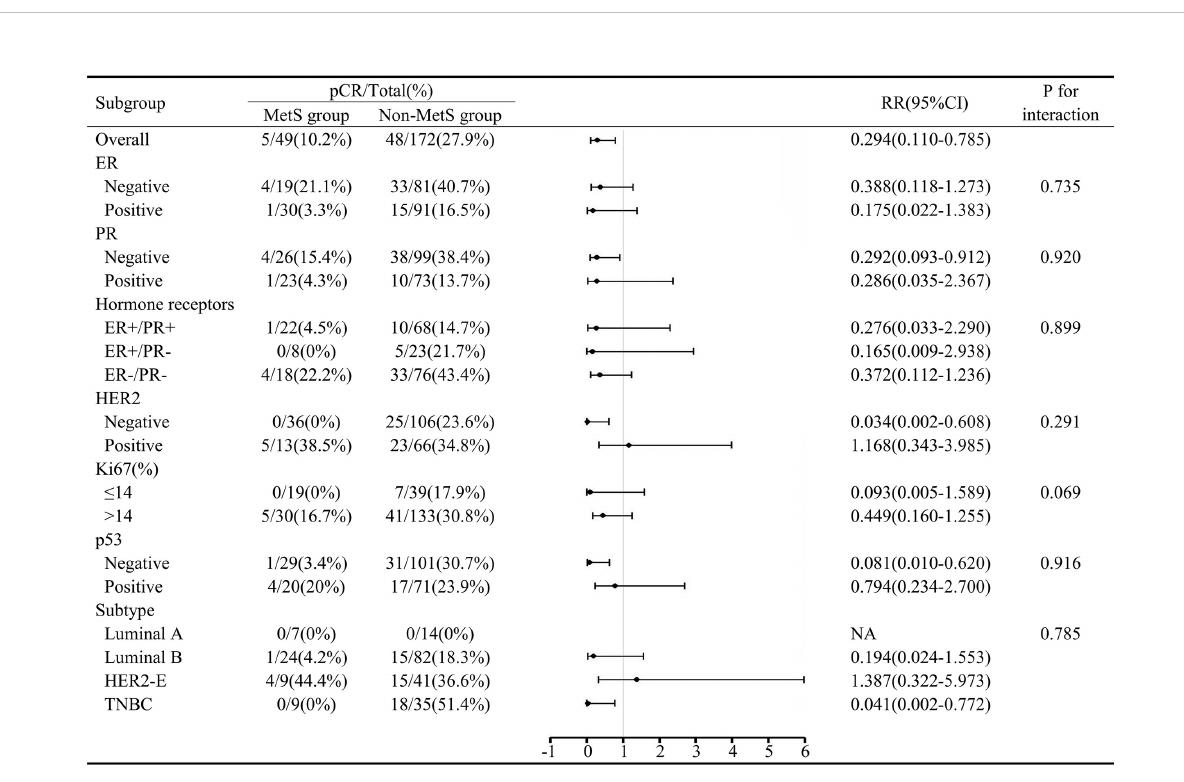
FIGURE 1 Subgroup analysis of MetS and pCR. MetS, metabolic syndrome; pCR, pathologic complete response; RR, risk ratio; CI, con fi dence interval; ER, estrogen receptor; PR, progesterone receptor; HER2, human epidermal growth factor receptor 2; HER2-E, HER2-enriched; TNBC, triple negative breast